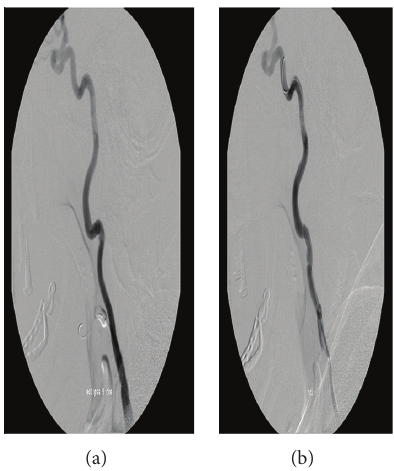
Figure 1: Loop in ICA (a) decreases on stretching by catheter in ICA (b), associated with a decrease in pulsatile tinnitus perception.